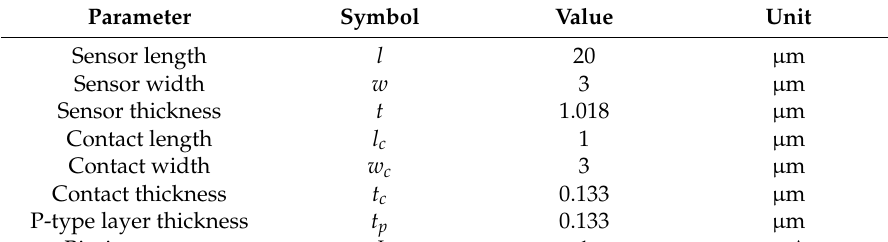
Table 2. Three-contact Hall device parameters and operating characteristics.